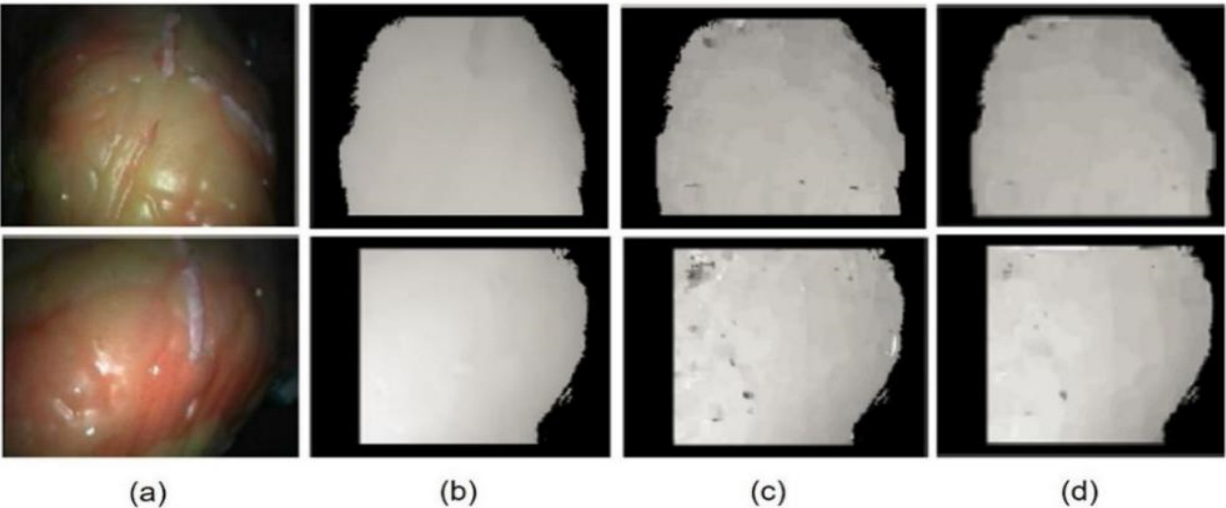
Figure 4. Census correspondence mismatch before and after improvement.